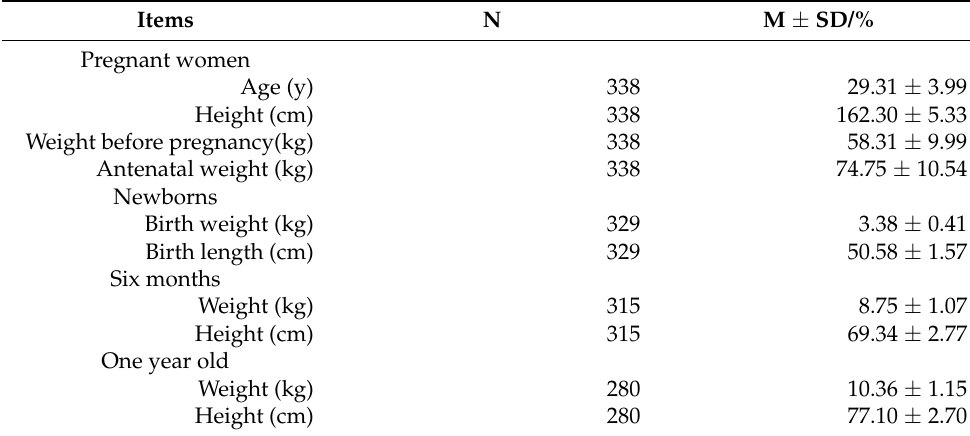
Table 1. The basic information of pregnant women and the height and weight of newborns and